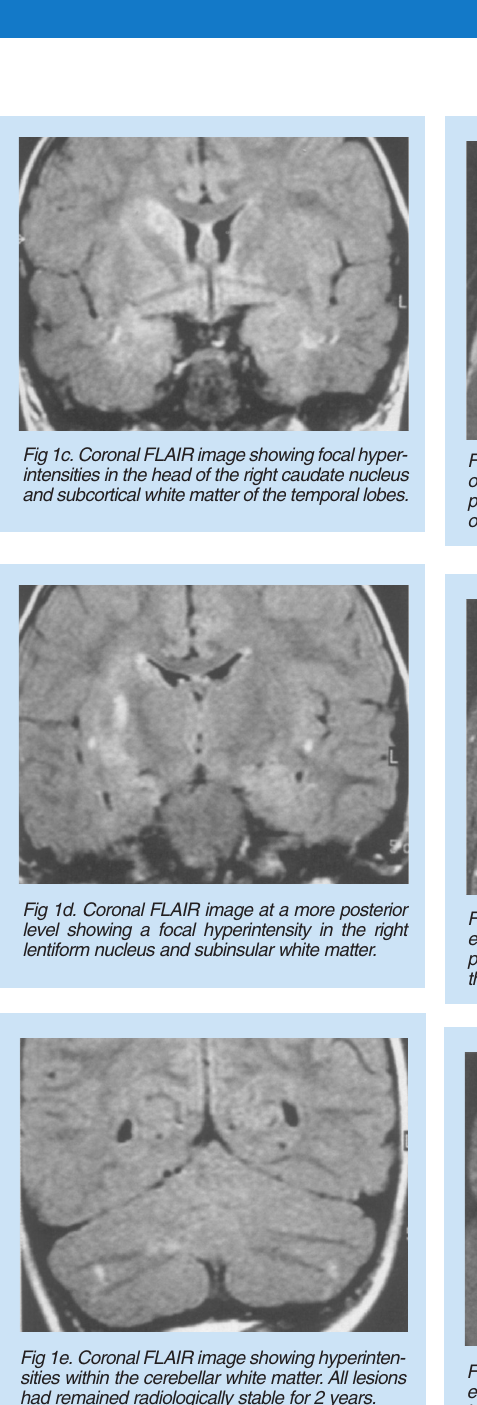
Fig 2e. Axial gadolinium enhanced T1-weighted image at a higher level showing dysplasia of the right hemicalvarium with associated enlargement of the surface sulci and right lateral ventricle sec- ondary to the increased hemicalvarial